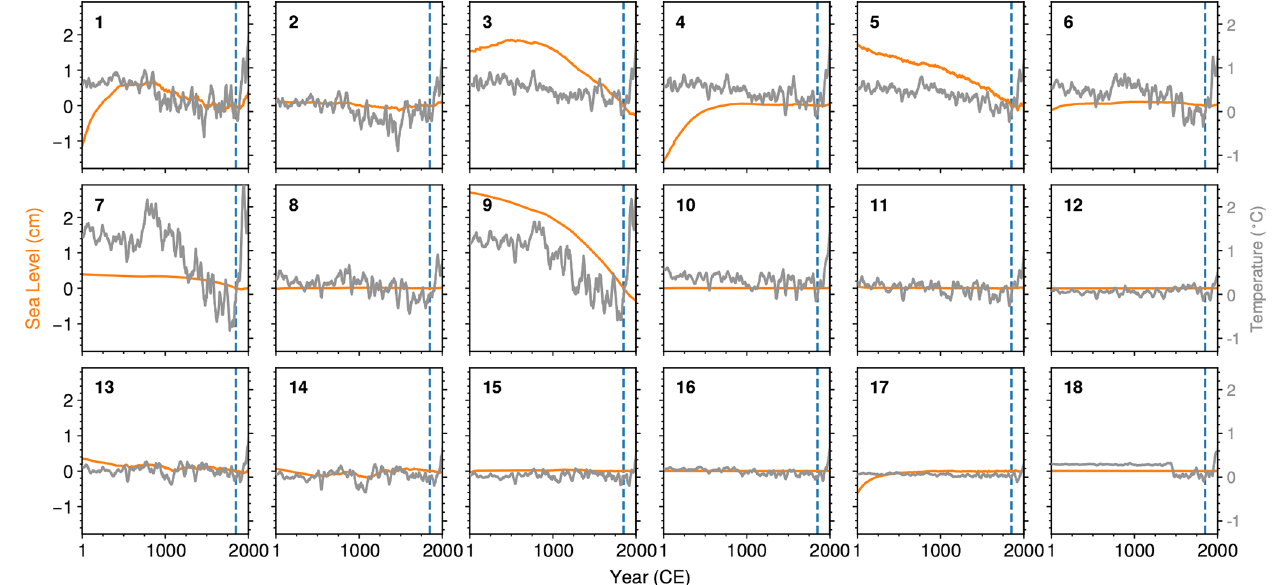
Figure 6. Sea-level equivalent of glacier volume changes in the CE for the 18 RGI regions considered in the glacier model (orange) and the glacier area-weighted surface temperature (LMR) over each of the glacier regions in the RGI (grey). The number on the top left of each panel indicates the corresponding RGI region. Note that a 31-year low-pass filter is applied on surface temperature, but the original yearly simulation is shown for the glacier sea-level contribution. All curves are referenced to the 1841–1860 CE mean (dashed blue line). Glacier regions, as listed in RGI, are (1) Alaska, (2) western Canada and the USA, (3) Arctic Canada north, (4) Arctic Canada south, (5) Greenland periphery, (6) Iceland, (7) Svalbard, (8) Scandinavia, (9) Russian Arctic, (10) North Asia, (11) Central Europe, (12) Caucasus and Middle East, (13) Central Asia, (14) South Asia West, (15) South Asia East, (16) low latitudes, (17) Southern Andes, (18) New